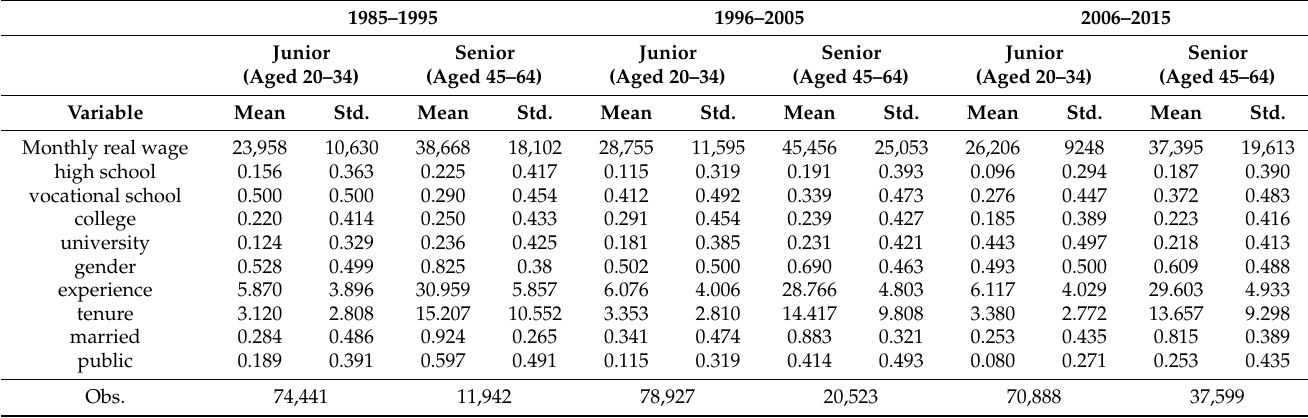
Table 1. General Statistics of Three Decades of Junior and Senior